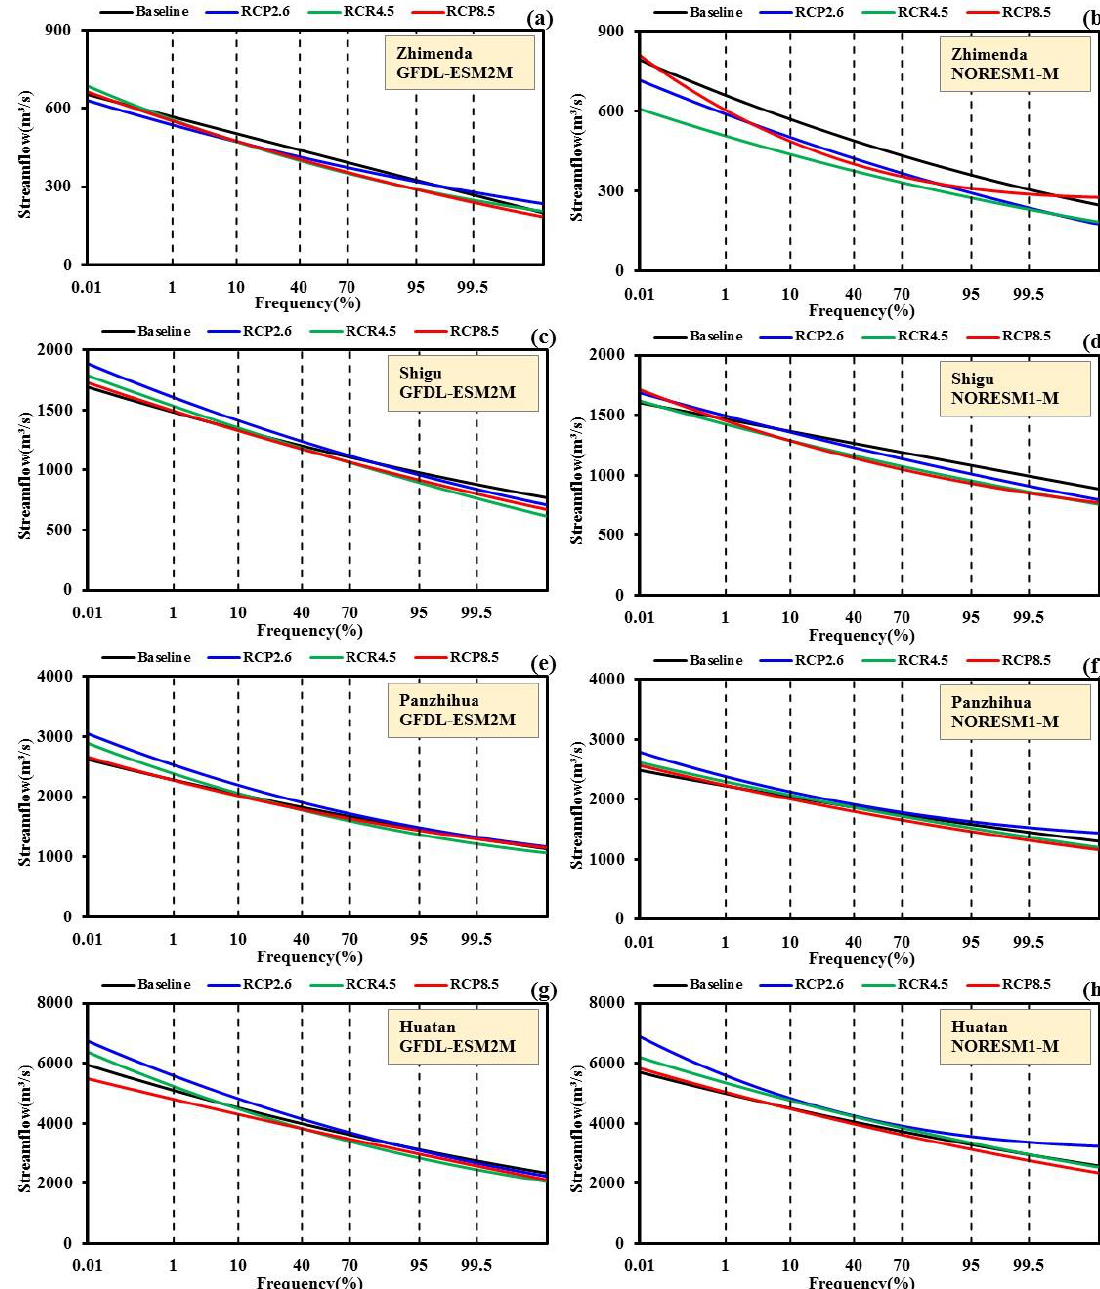
Figure 17. PIII frequency distribions of annual mean streamflow in Zhimenda ( a , b ), Shigu ( c , d ), Panzhihua ( e , f ) and Huatan ( g , h ) under different climate change scenarios. Table 4. Percentage changes (%) in streamflow under different scenarios.